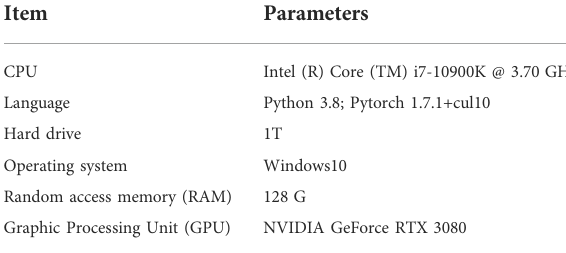
TABLE 1 Experimental platform for training TLVGGNet